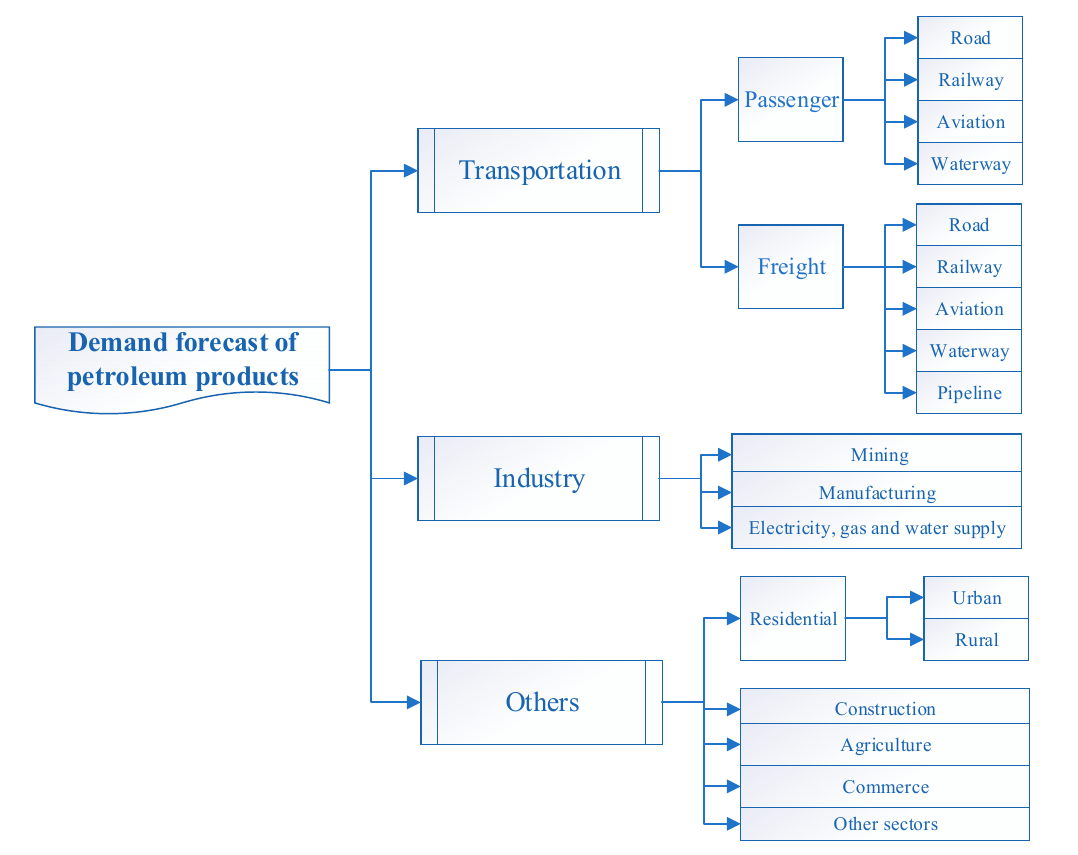
Figure 5. The division of sectors for petroleum products demand forecasting.